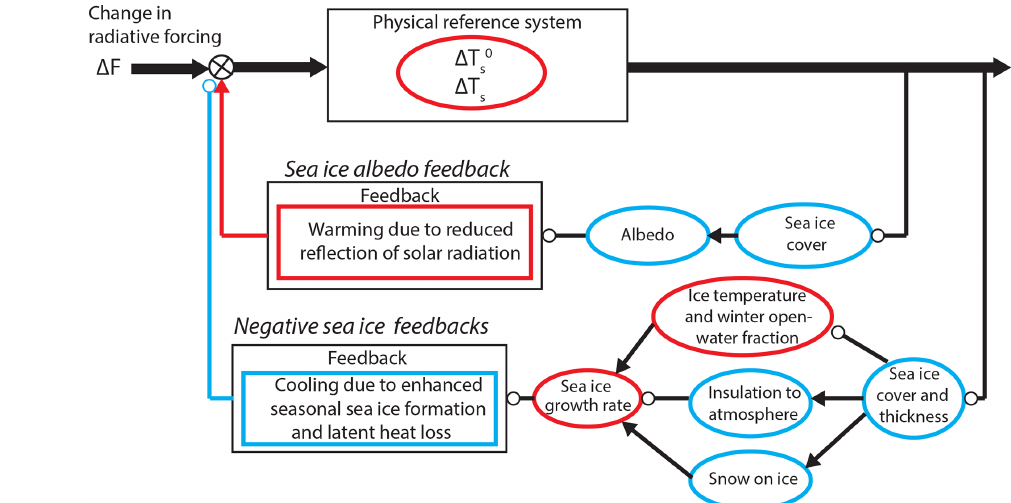
Figure 9. Schematic of the sea ice feedbacks. Arrows indicate positive coupling; open circles indicate negative coupling. Changes in state variables are indicated by ellipses, changes in processes by rounded rectangles. Red indicates increasing values of variables, strengthening of processes, or positive feedbacks; blue indicates the opposite. The change in surface air temperature (cid:49)T s in the presence of feedback is different from the change (cid:49)T 0 s without feedback.